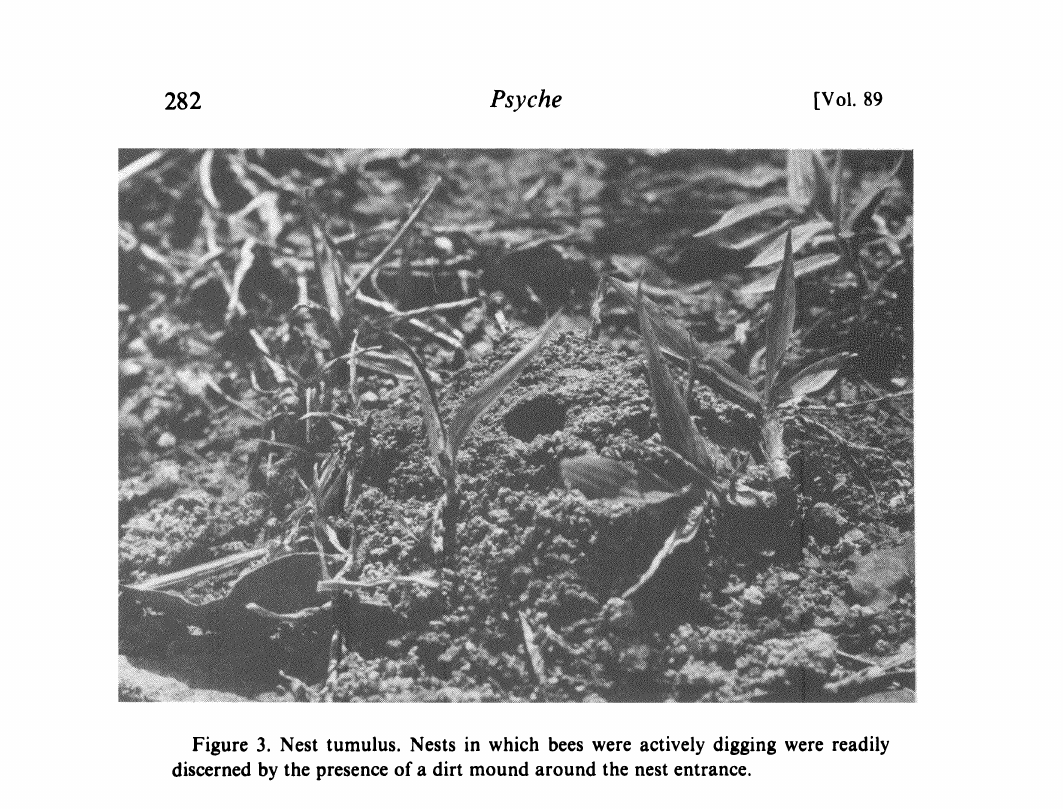
Figure 3. Nest tumulus. Nests in which bees were actively digging were readily discerned by the presence of a dirt mound around the nest